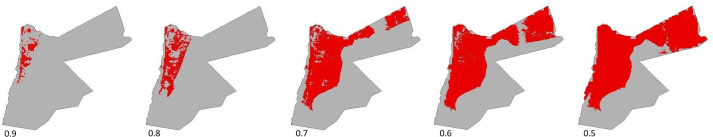
Geographic areas suitable for Phlebotomus papatasi occurrence using suitability cut-offs of 0.9 to 0.5.